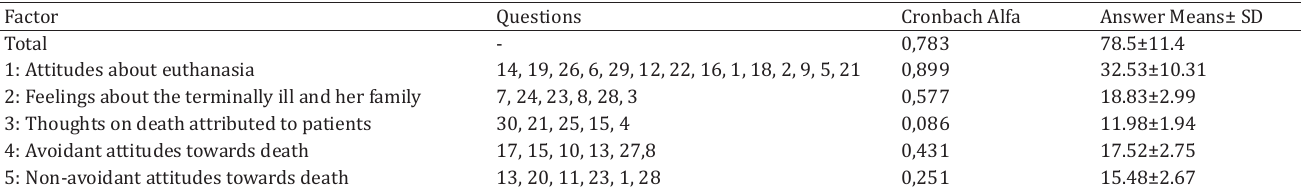
Attitude scale factors and question distributions regarding euthanasia, death, and the terminally patient.